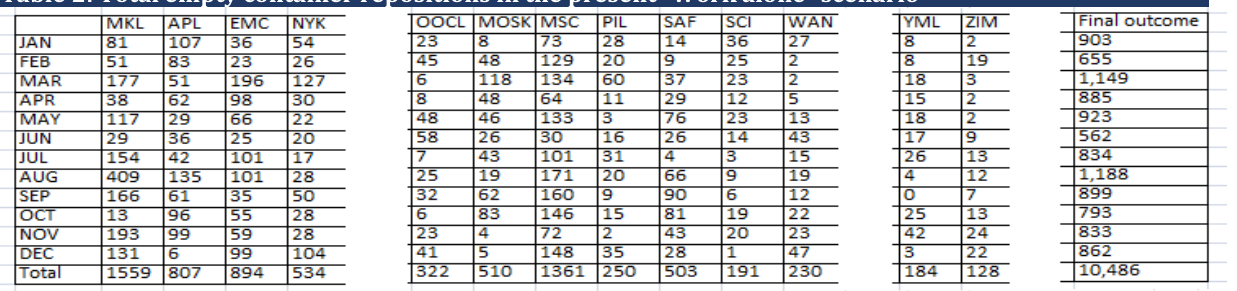
Table 2: Total empty container repositions in the present “Work alone” scenario